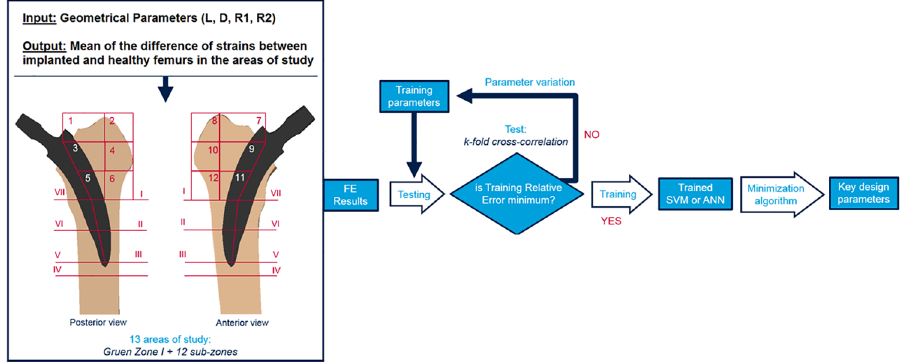
Fig 6. Flow chart of a typical training task using MLT. During the training, the error of the output prediction associated to the input parameters is minimized.Once the MLT is trained, the minimization algorithmfind the best combination of design parameters to reducethe proximalstress